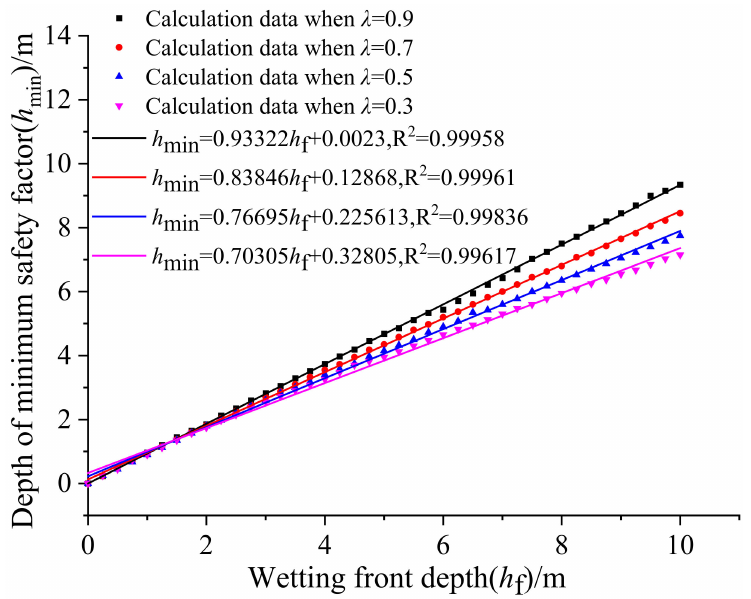
Figure 9. Depth ( h min ) of the potential slip surface versus the wetting front